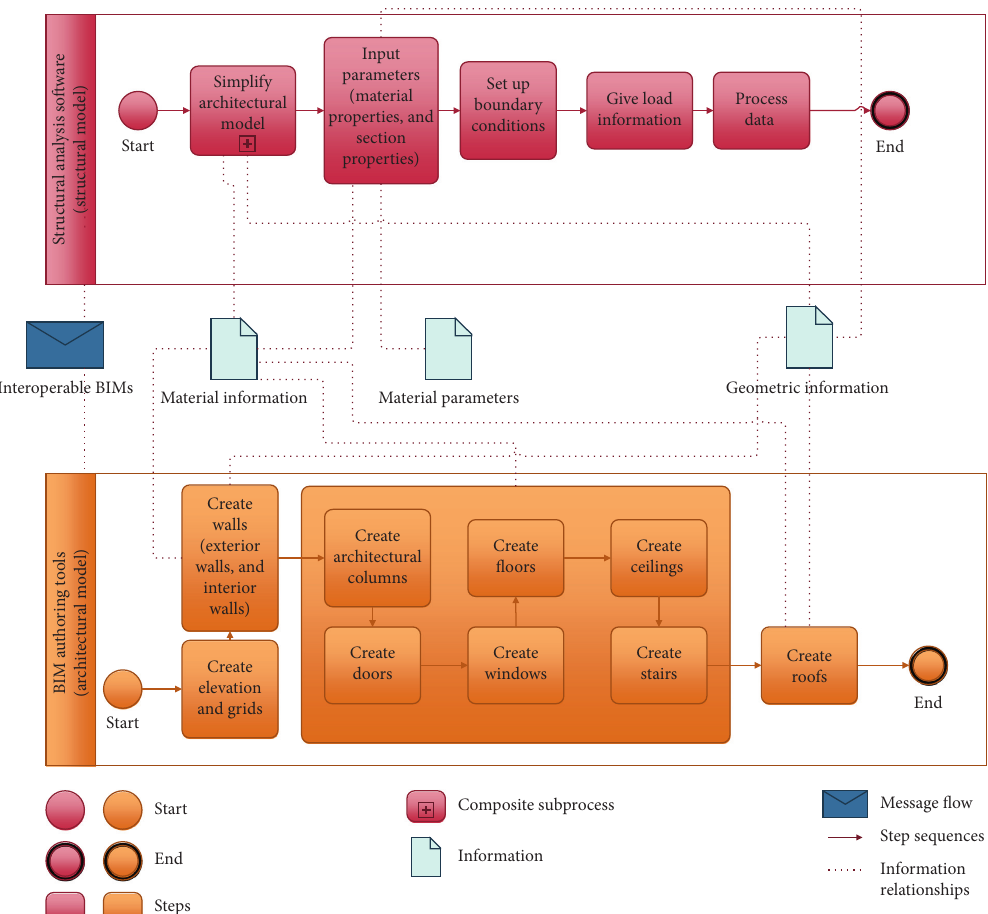
Figure 1: A BPMN representation of geometric and material information